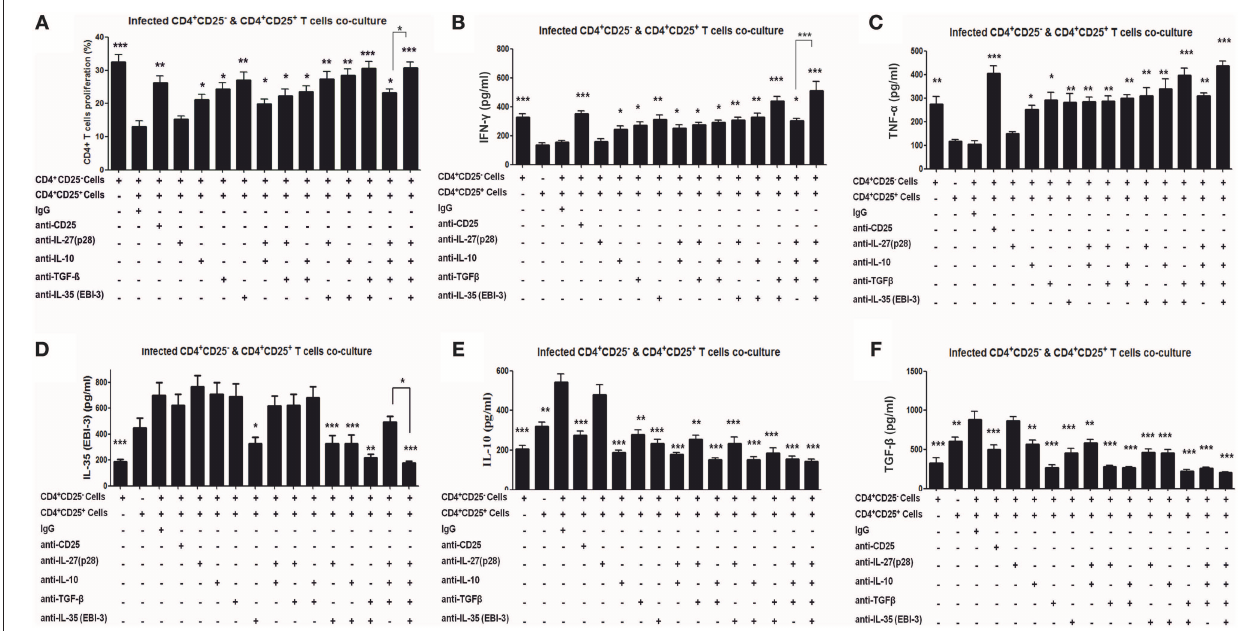
FIGURE 4 | Proliferative and cytokine responses of CD4 + CD25 − T cell, co-cultured with CD4 + CD25 + T, in the presence of neutralizing antibodies. Indicated neutralizing antibodies were added (20 µ g/ml each) in the co-culture of splenic CD4 + CD25 − T cells (CFSE labeled) and CD4 + CD25 + T cells (1:1 ratio) obtained from 4 months infected mice (as described in Materials and Methods). After 96h cells were processed for CFSE based cell proliferation assay (A) and the culture supernatants were collected for estimation of cytokines, IFN- γ (B) TNF- α (C) IL-10 (D) , TGF- β (E) and EBI-3 (F) . Data represented as means ± SE for five mice per group are representative of three independent experiments with similar results. * P < 0.05; ** P < 0.01; *** P < 0.001 between the neutralized and IgG control groups were assessed by two tailed Student’s T